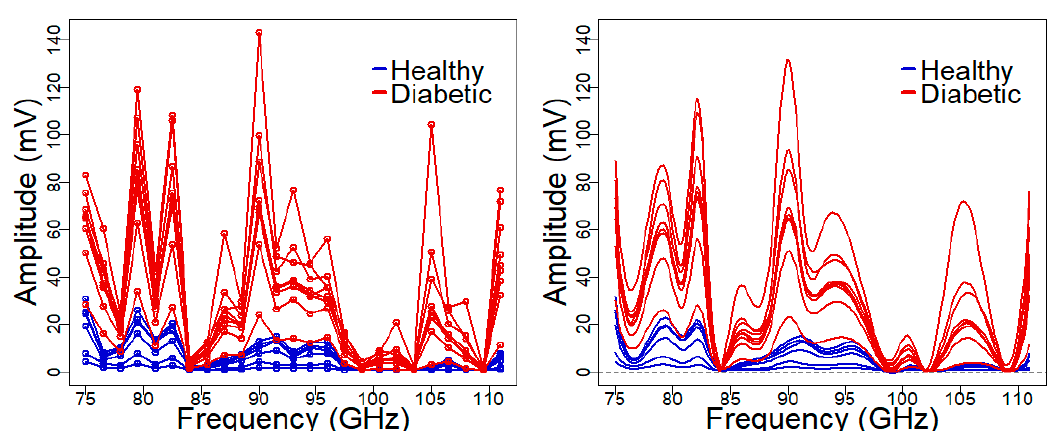
Figure 3. Measured amplitude transmittance spectrum. Raw spectral data collected by the spectroscopy system ( left panel ), and the estimated curves using regression splines with a cubic B-spline basis defined on 17 breakpoints ( right panel ).